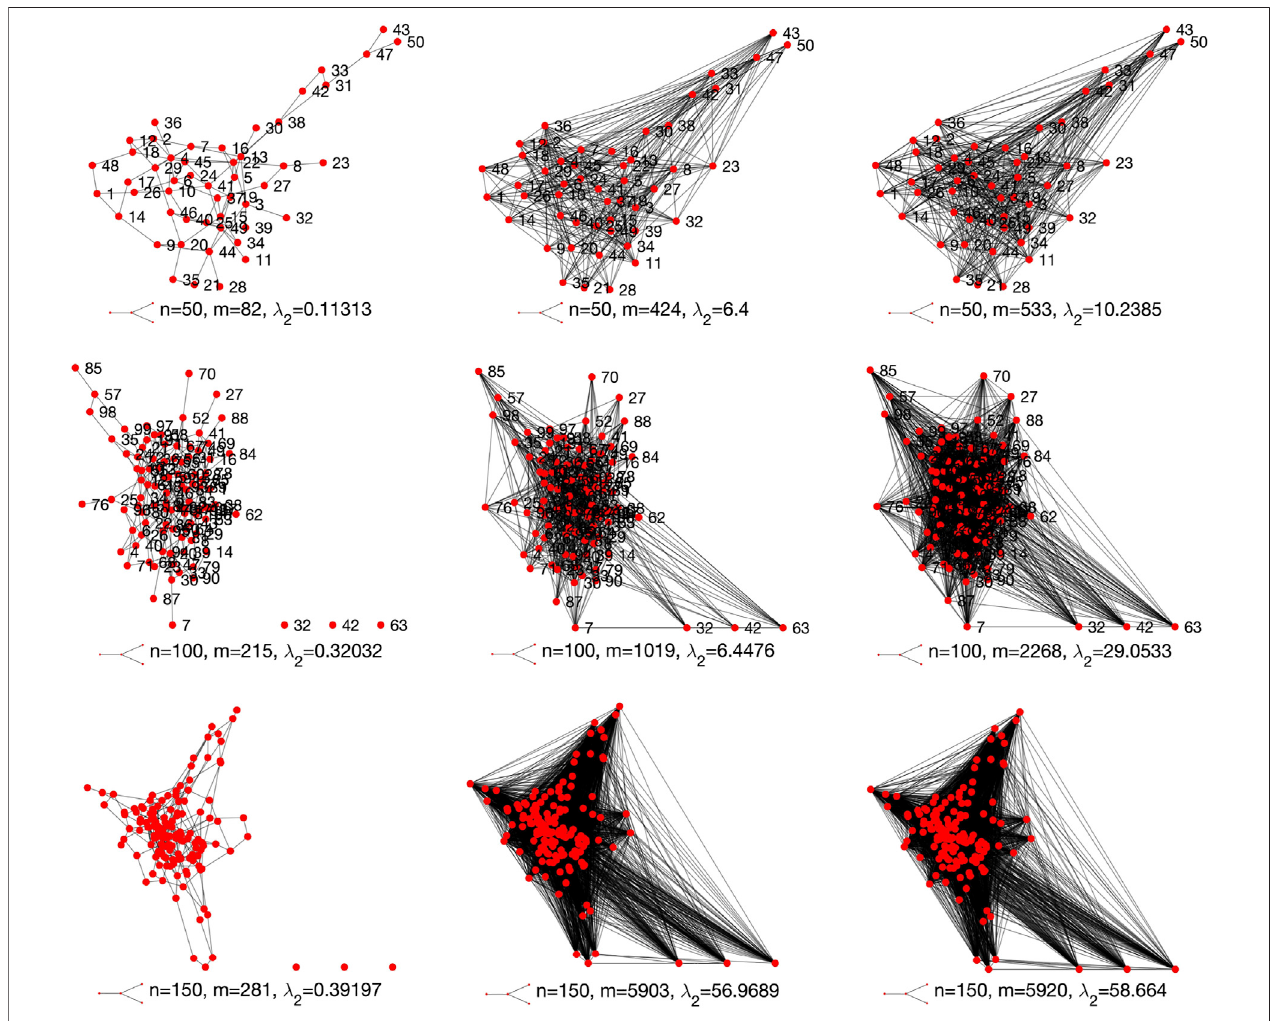
FIGURE 11 | Original ( fi rst column) and optimized structures (second and third columns) of the Erd ő s – Rényi networks for d (cid:2) 4.